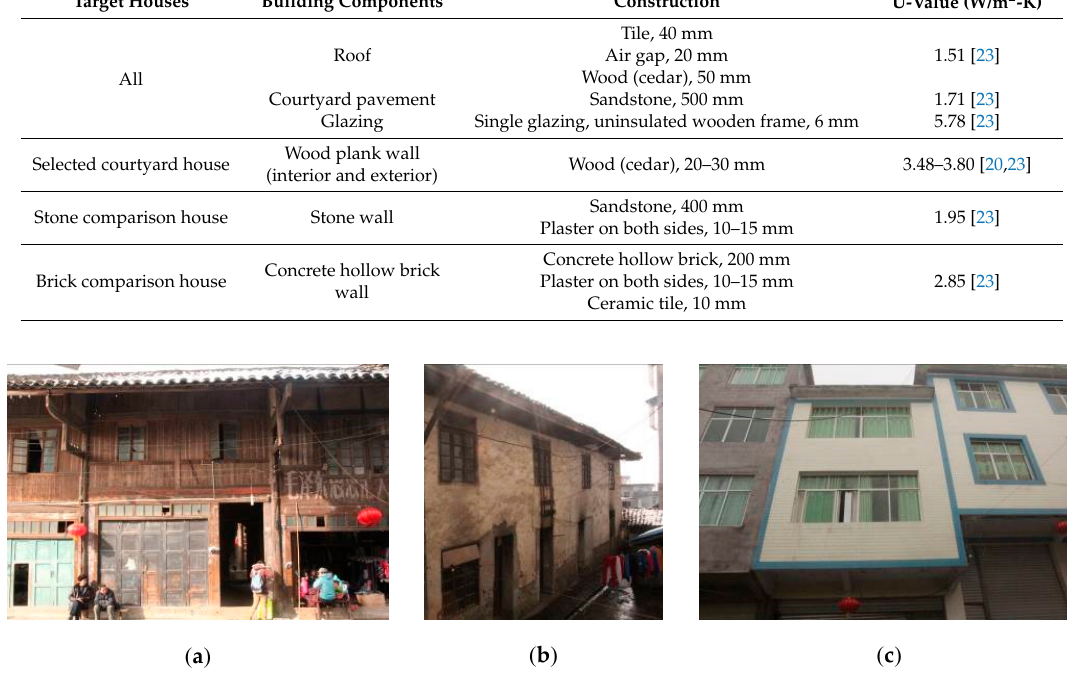
Figure 4. Images of: ( a ) wood plank, ( b ) stone, and ( c ) hollow brick walls.